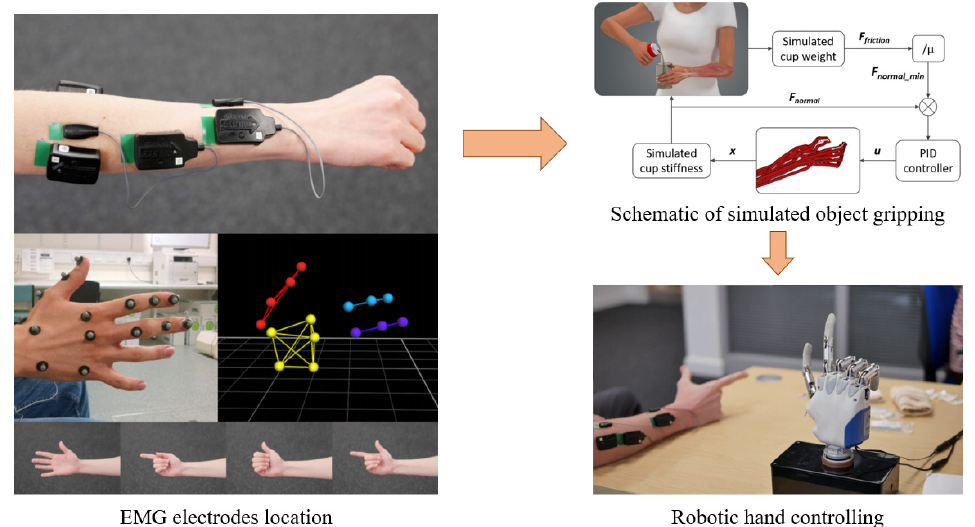
Figure 14. The schematic of utilizing biomechanical based and EMG centered multisensory technique in controlling a robotic hand, adopted from [134] .